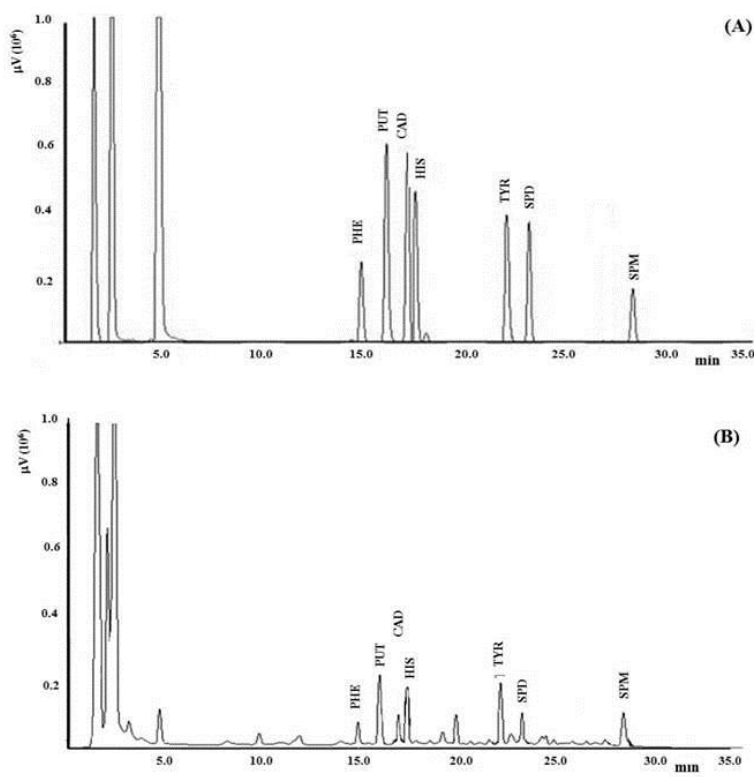
Figure 2. LC-UV chromatogram of biogenic amines (BAs) standard mixture at concentration of 100 µ g mL − 1 ( A ) and sample 1 ( B ). The chromatogram was obtained employing gradient conditions as specified in the Materials and Methods section.